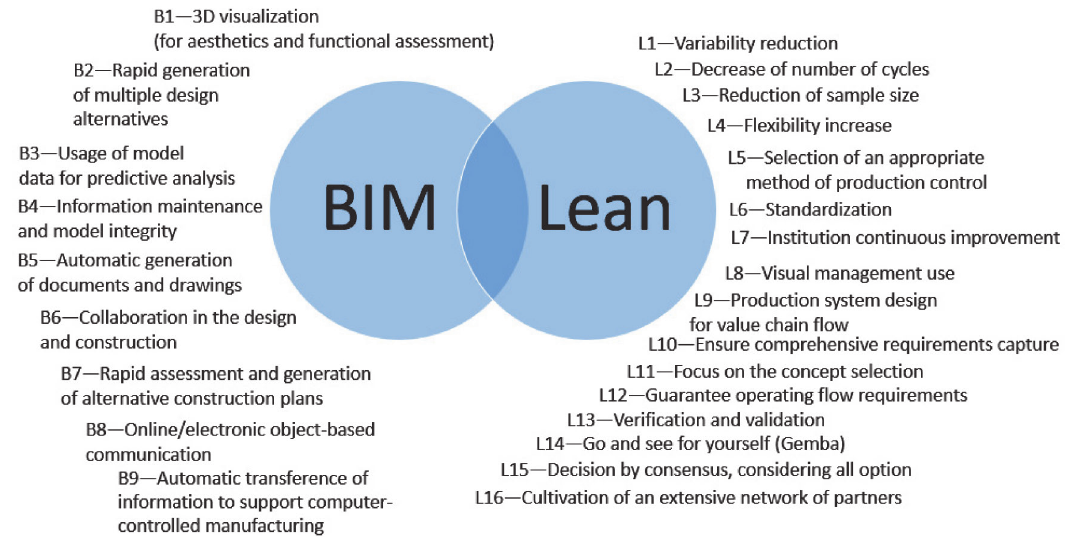
Figure 6. BIM functionalities and Lean principles. Source: adapted from Sacks et al . (2010)